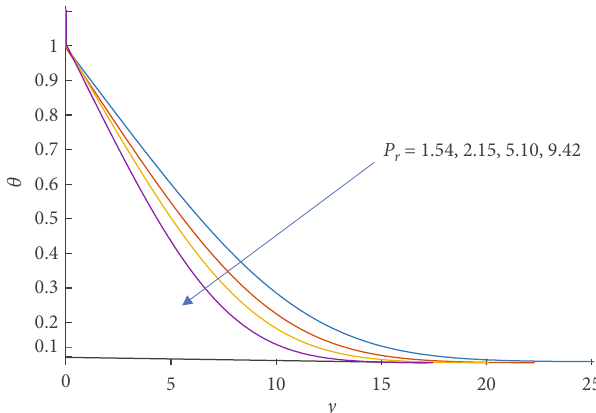
Figure 3: Distinct values of Pr for temperature fi eld when Ec = 0 : 1 , t = 0 : 2 , H = 2 , and F = 1 .